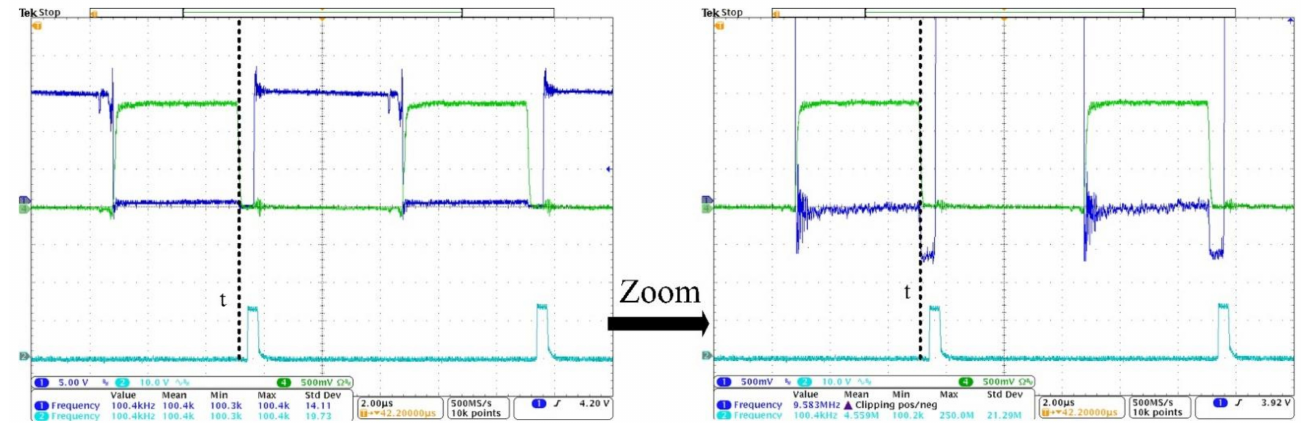
Figure 19. Waveforms of the SR driving signals without the proposed